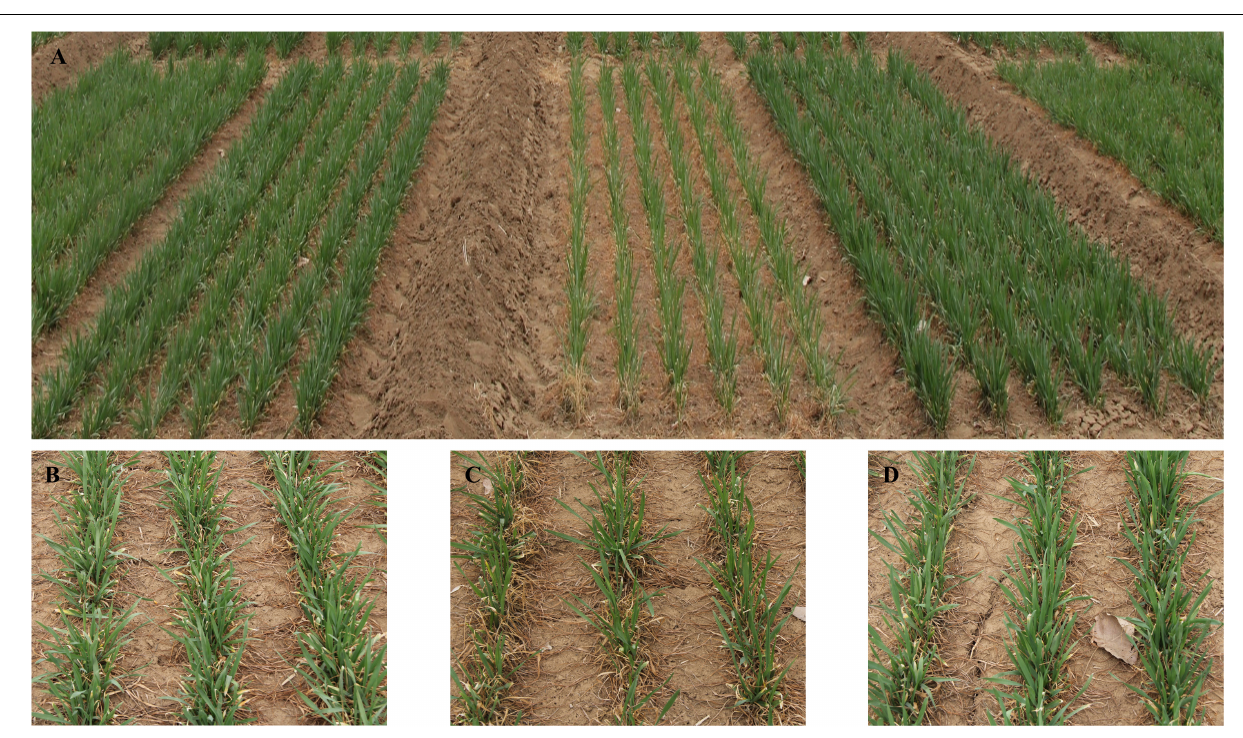
kernel number per spike ( Figure 6B ), but no effect on the other agronomic traits ( Figures 6D–E ). When no winter frost or light winter frost occurred, Shimai 12 exhibited a